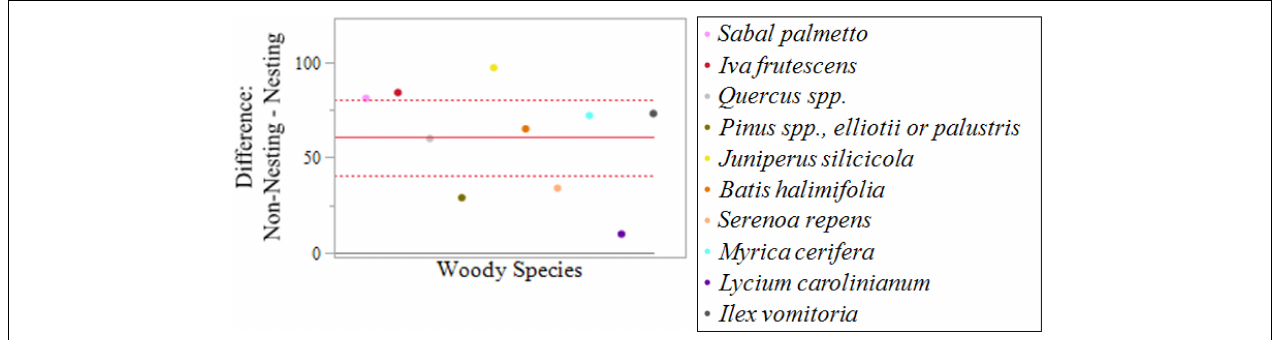
FIGURE 6 | Specialized matched-pairs t -testing comparing woody species composition of nesting and non-nesting sites with a |t| ratio of 6.93 with | t | < 0.0001. A specialized matched-pairs t -test resulted in a mean difference of 52.3 represented by the solid red line and a 95% confidence interval of (40.8, 80.2) represented by the dotted red